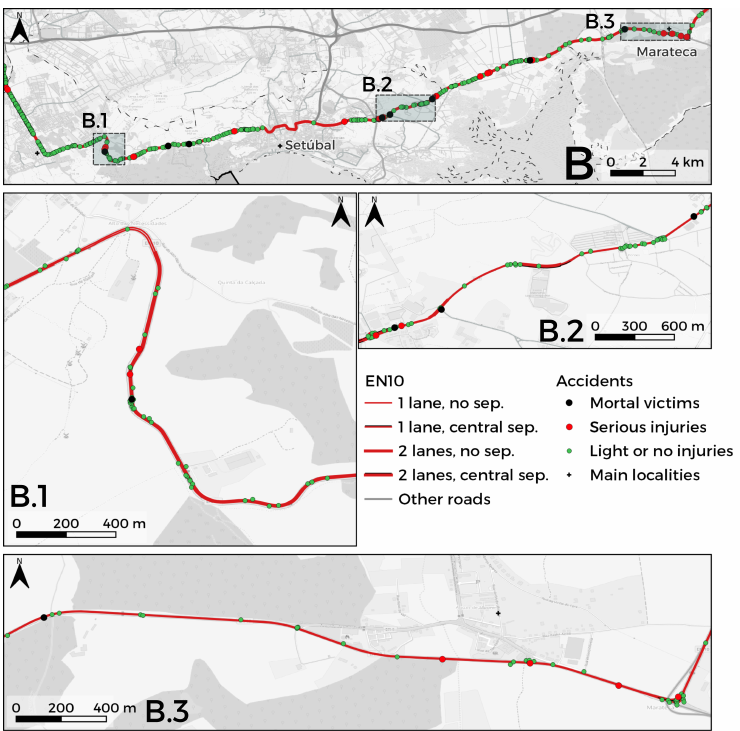
Figure 3. Section B and its main areas ( B.1 – B.3 ); RTA between 2016 and 2019 according to their